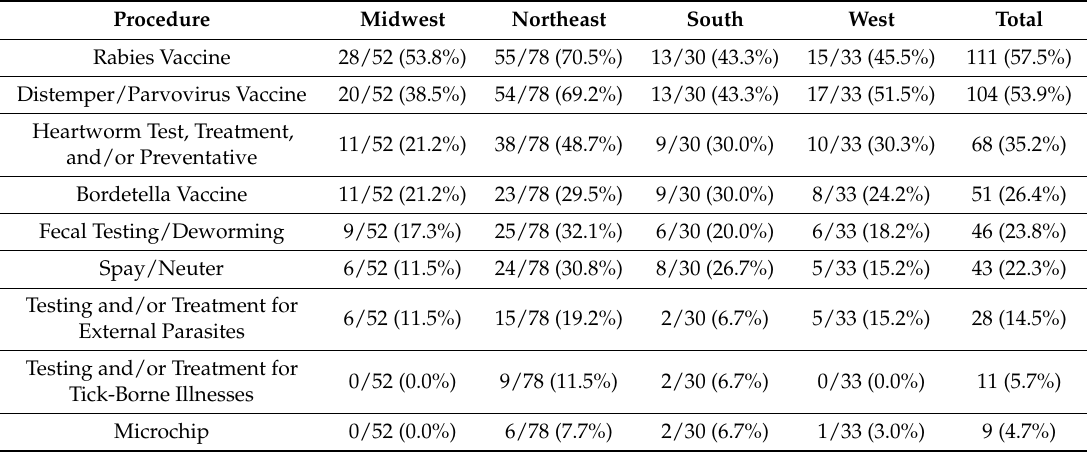
Table 3. The number of participants within each region and overall who stated their organizations had pre-transfer medical requirements (percentages in